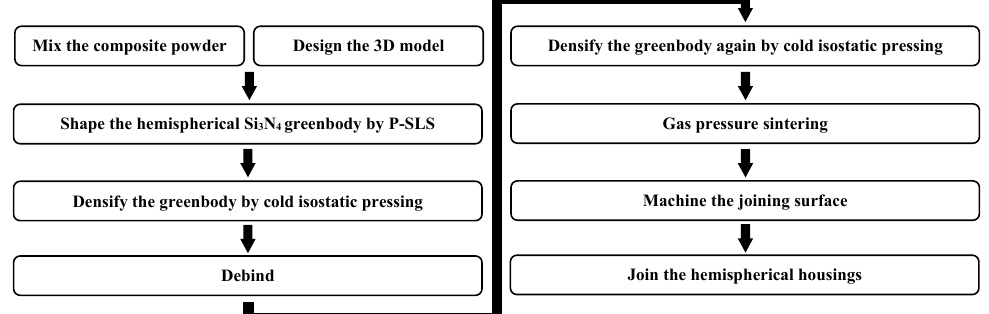
Figure 1. Preparation process of Si 3 N 4 ceramic floatation spheres.